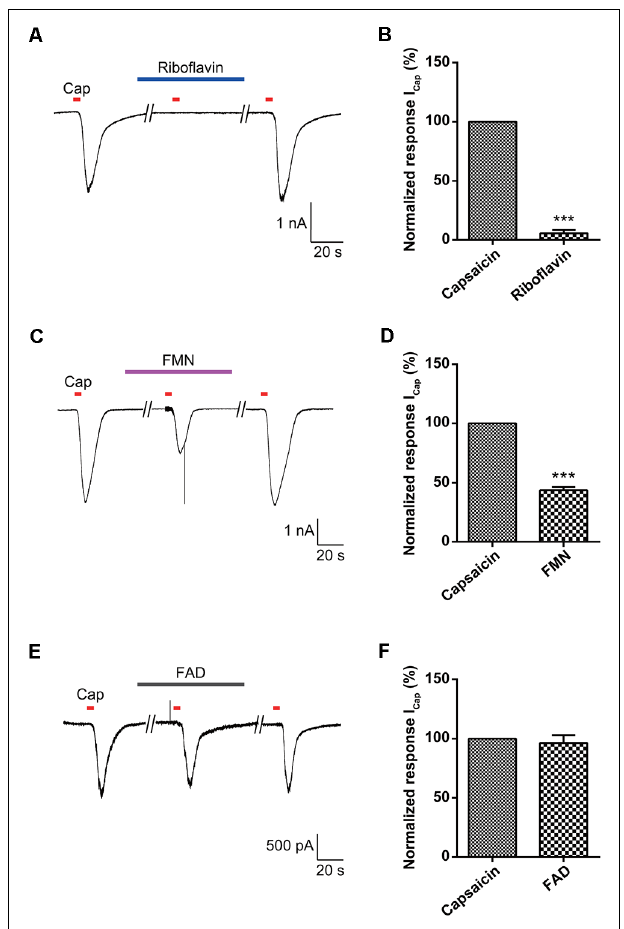
FIGURE 5 | Effect of riboflavin, FMN, and FAD on capsaicin-induced currents in transient receptor potential vanilloid 1 (TRPV1)-transfected HEK293 cells. The responses to capsaicin (Cap, 200 nM) in the absence and presence of (A) riboflavin (1 µ M), (C) FMN (1 µ M), and (E) FAD (1 µ M) are shown in TRPV1-transfected HEK293 cells. The normalized response of capsaicin currents induced by the second stimulation compared to those with the first stimulation in each neuron is shown (B,D,F) . Results are presented as the mean ± SEM (*** p < 0.001, n = 3, unpaired t -test). Cap, capsaicin; FMN, flavin mononucleotide; FAD, flavin adenine